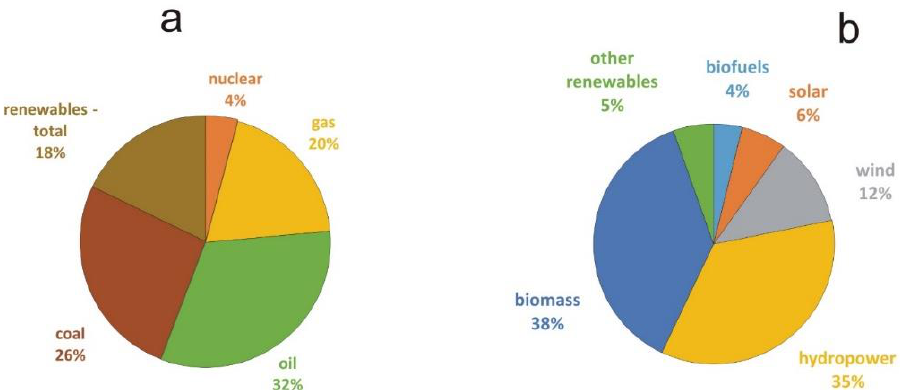
Figure 1. ( a ) Global production of energy in 2019 and ( b ) global production of energy from renewables in 2019 [1].